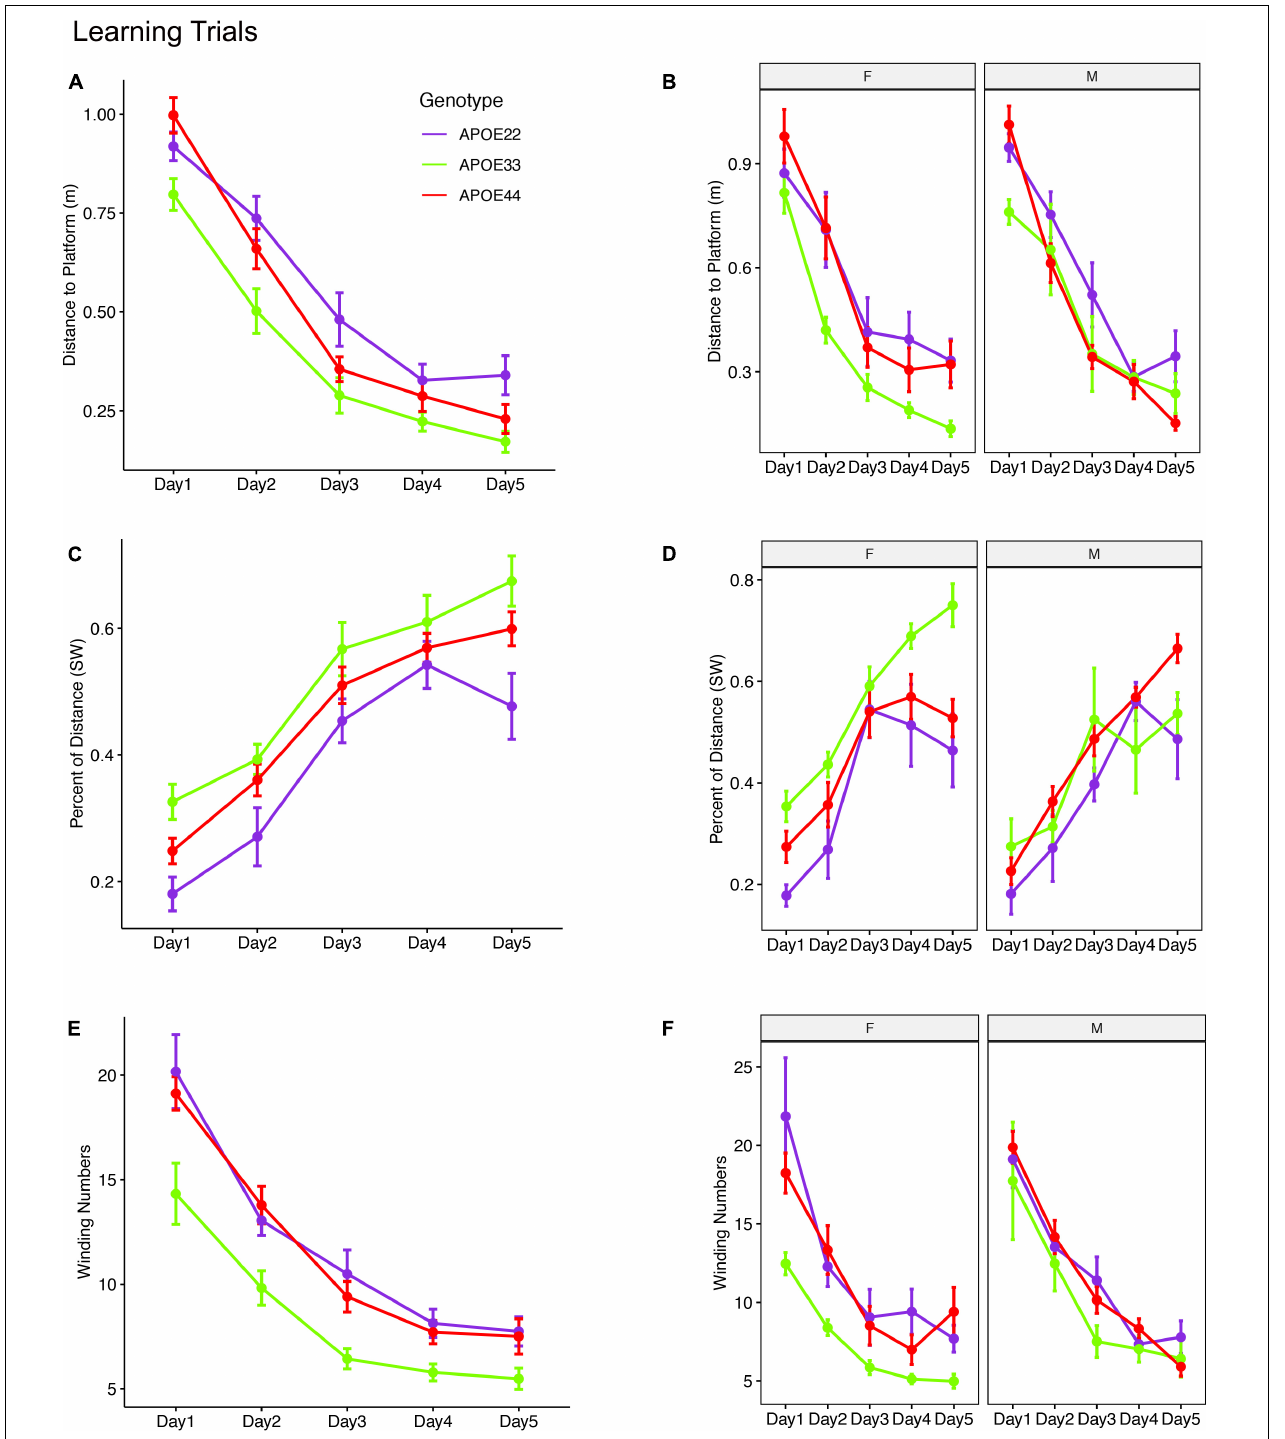
FIGURE 2 | Learning trials. Mice swam shorter distances over the 5 testing days until reaching the hidden platform, indicating that they were learning (A,B) . Meanwhile, the percentage time swam in the target quadrant increased with time (C,D) . The absolute winding number clearly discriminated the APOE3 mice relative to APOE2 and APOE4 carriers, which used more similarly shaped trajectories (E,F) . The effects were larger in females across the 5 days. F, female; M, male. Graphs show mean ± standard error.